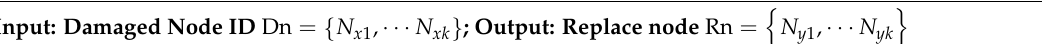
Algorithm 1. DCRS Repair Algorithm